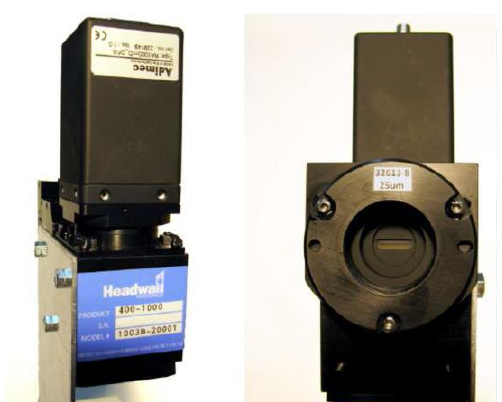
Figure 1. The push-broom hyperspectral imager- the Headwall MicroHyperspec A-series VNIR